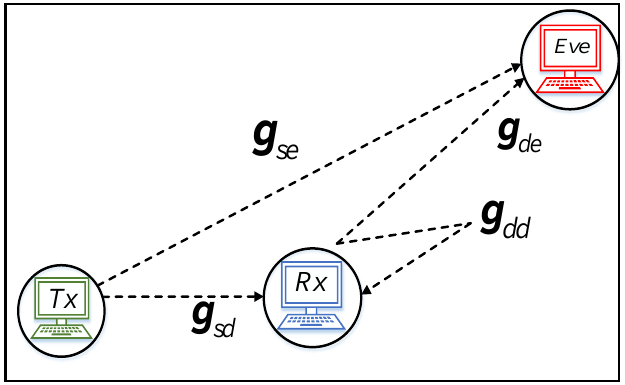
Figure 2. A single-antenna three-node wireless transmission with a full-duplex